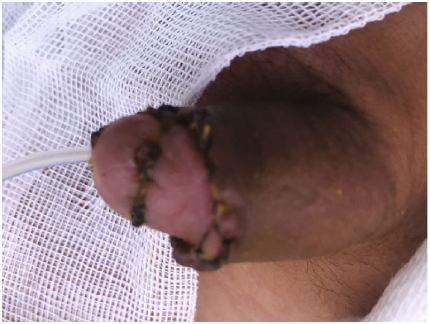
Figure 3: Follow-up image after 3 weeks of operation.